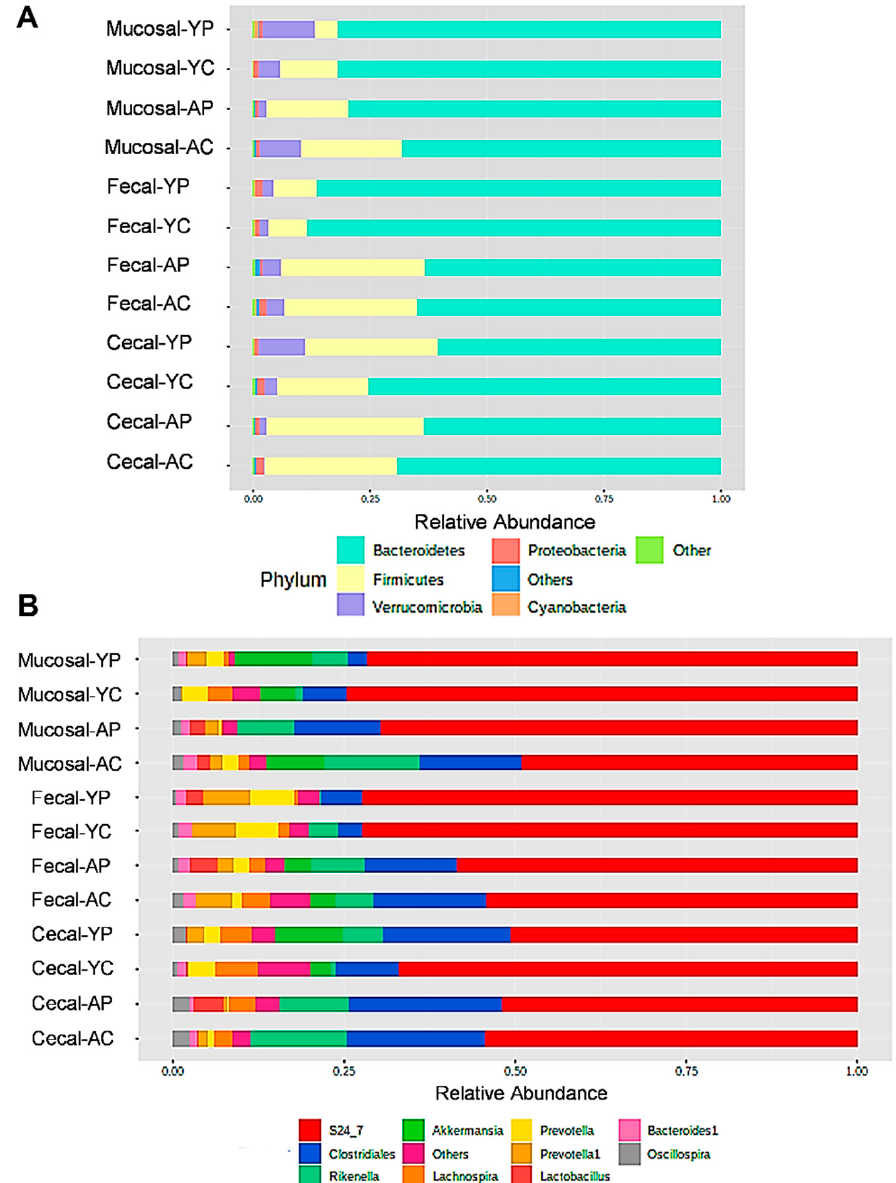
Figure 3. Fecal, mucosal, and cecal microbiota composition profiles in young and aging mice at the phylum ( A ) and genus levels ( B ) in control and probiotic-treated groups, revealed by 16S rRNA gene sequencing (each color represents bacterial phylum and/or genus). (YC) Young control group, (YP) young probiotic group, (AC) aging control group, and (AP) aging probiotic group.